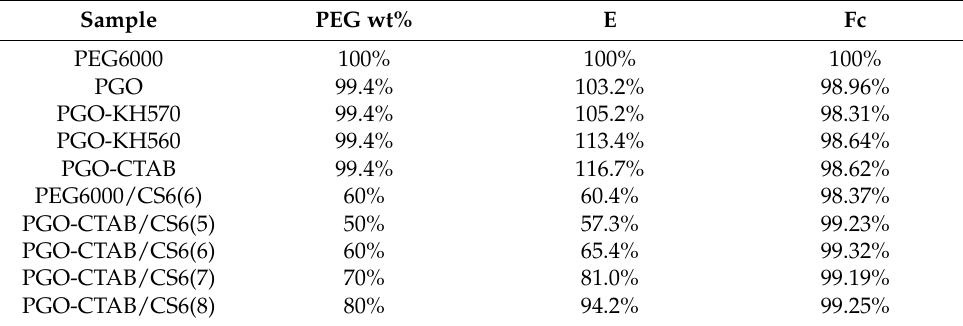
Table 3. Loading efficiency E and the crystallinity of PEG Fc of various PCMs.